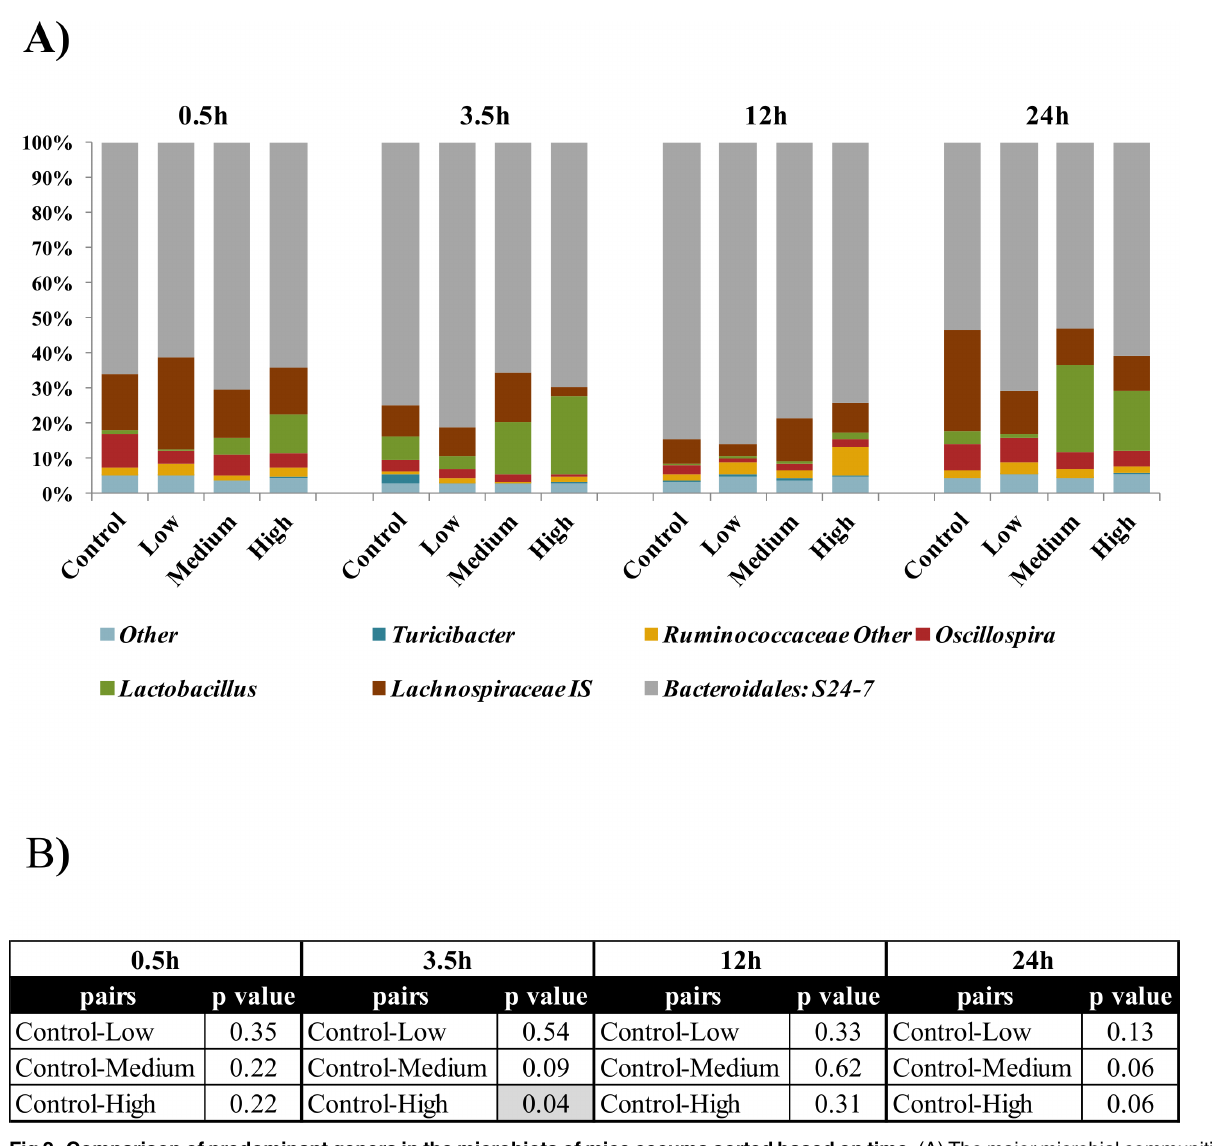
Fig 2. Comparison of predominant genera in the microbiota of mice cecums sorted based on time. (A) The major microbial communities of mouse cecum content at genus level in the control group and L . casei 32G groups; 10 6 CFU/ mouse (low), 10 7 CFU/ mouse (medium) and 10 8 CFU/ mouse (high), at 0.5, 3.5, 12, and 24 h after the last administration. Only genera with over 5% of the total bacteria are presented (n: 6 for each bar). (B) Pair wise comparison of each group. Statistical p-values were assessed using a Monte-Carlo test with 10000 replicates. The values with p (cid:2) 0.05 are